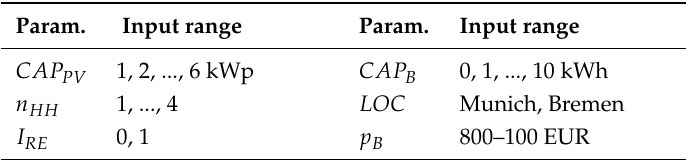
Table 3. Sensitivity